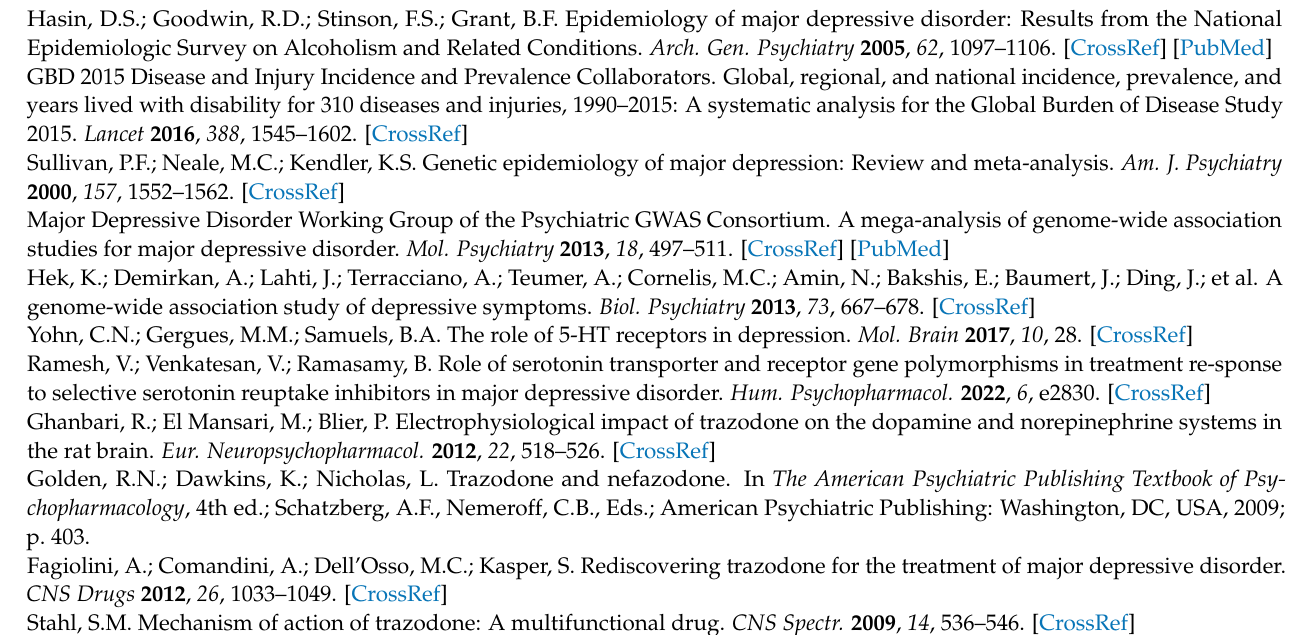
results by DS. Table S2. TZD-serotonin interactions result from DS. Table S3. The bond lengths of [(TZD)(DCQ)] were obtained through DFT. Table S4. The bond angles of the [(TZD)(DCQ)] were obtained through DFT. Table S5. Mulliken atomic charges of the [(TZD)(DCQ)] atoms. Figure S1. MO energy level diagram of the [(TZD)(DCQ)]